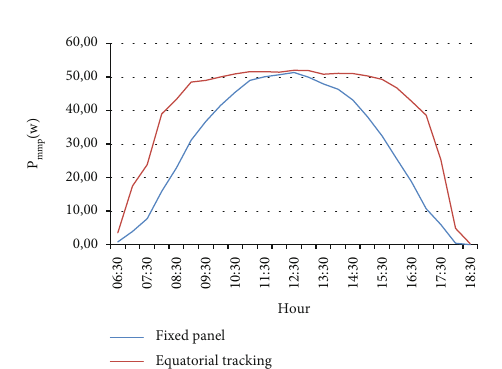
Figure 45: The comparison between a fi xed solar panel and that in